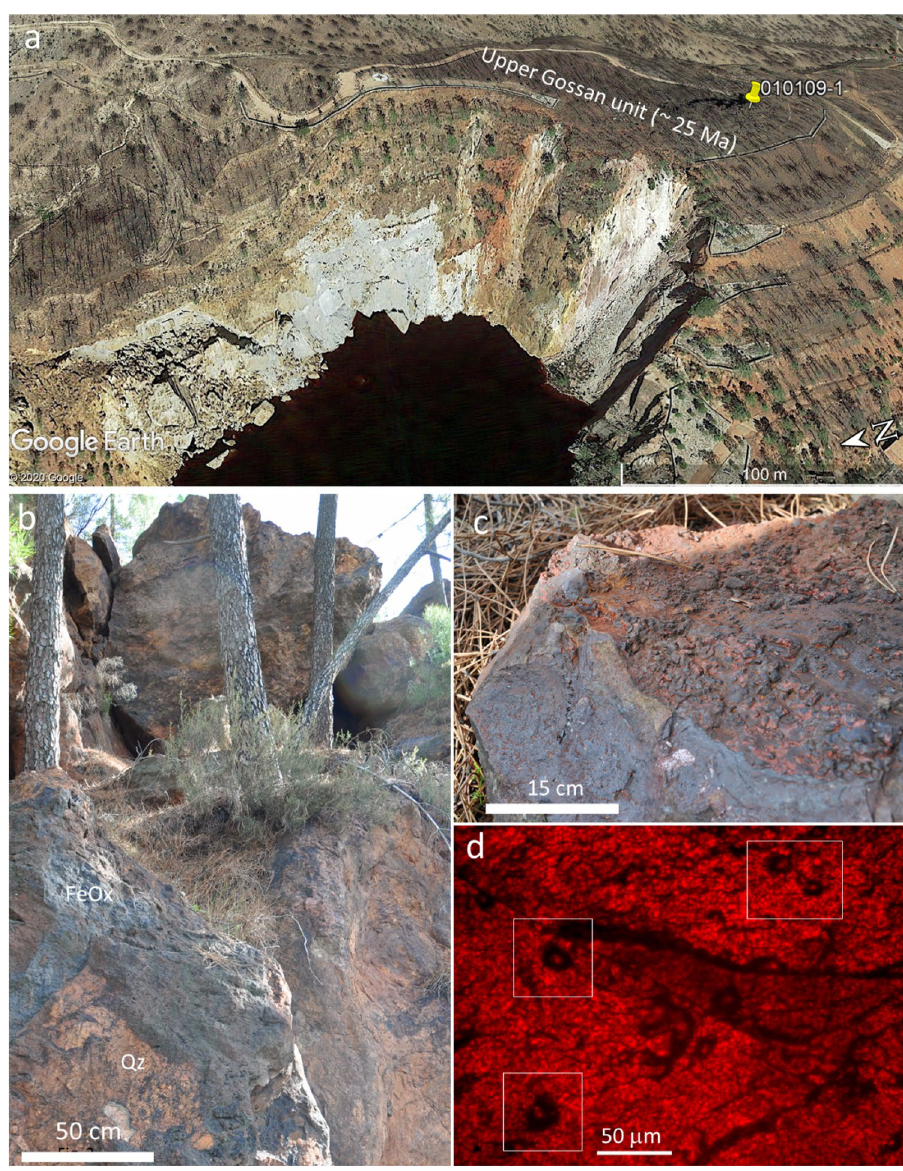
Figure 1. Occurrence of the Upper Gossan deposits in the Peña de Hierro area. ( a ) Google Earth satellite image of the Upper Gossan unit topping the Peña de Hierro where the sample 010,109–1 was collected. ( b ) Outcrop photograph of the lower part of the Upper Gossan unit consisting of iron oxide deposits (FeOx) infilling cracks and voids left by the alteration of sulfide materials, which are limited by quartz-rich materials (Qz). ( c ) Sample 010,109- was collected in the gossan material cropping out at a higher location in the Upper Gossan; it occurs as a lenticular body with internal massive fabric and topped with cm-sized popcorn and millimeter-thick filamentous structures. ( d ) Thin section of sample 010,109–1 around TA3 (see Fig. 7) showing a laminated fabric not recognized through observation by the naked eye; this sample contains different 30-micron ovoid elements of likely fungal origin; because they correspond with the preservation of filamentous structures, the ovoid sections suggest that they have the same